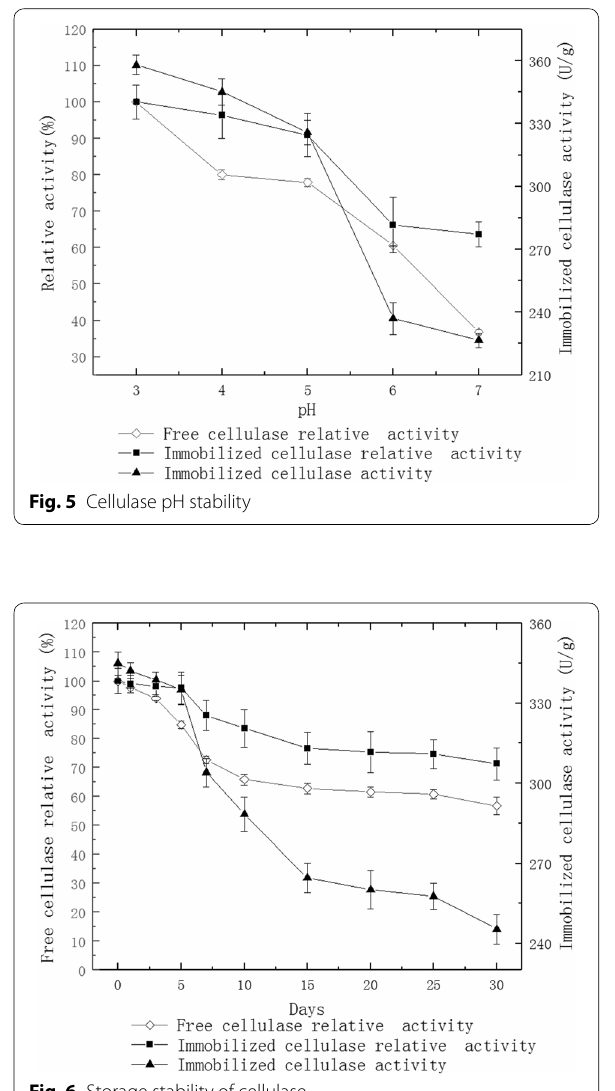
Fig. 6 Storage stability of cellulase